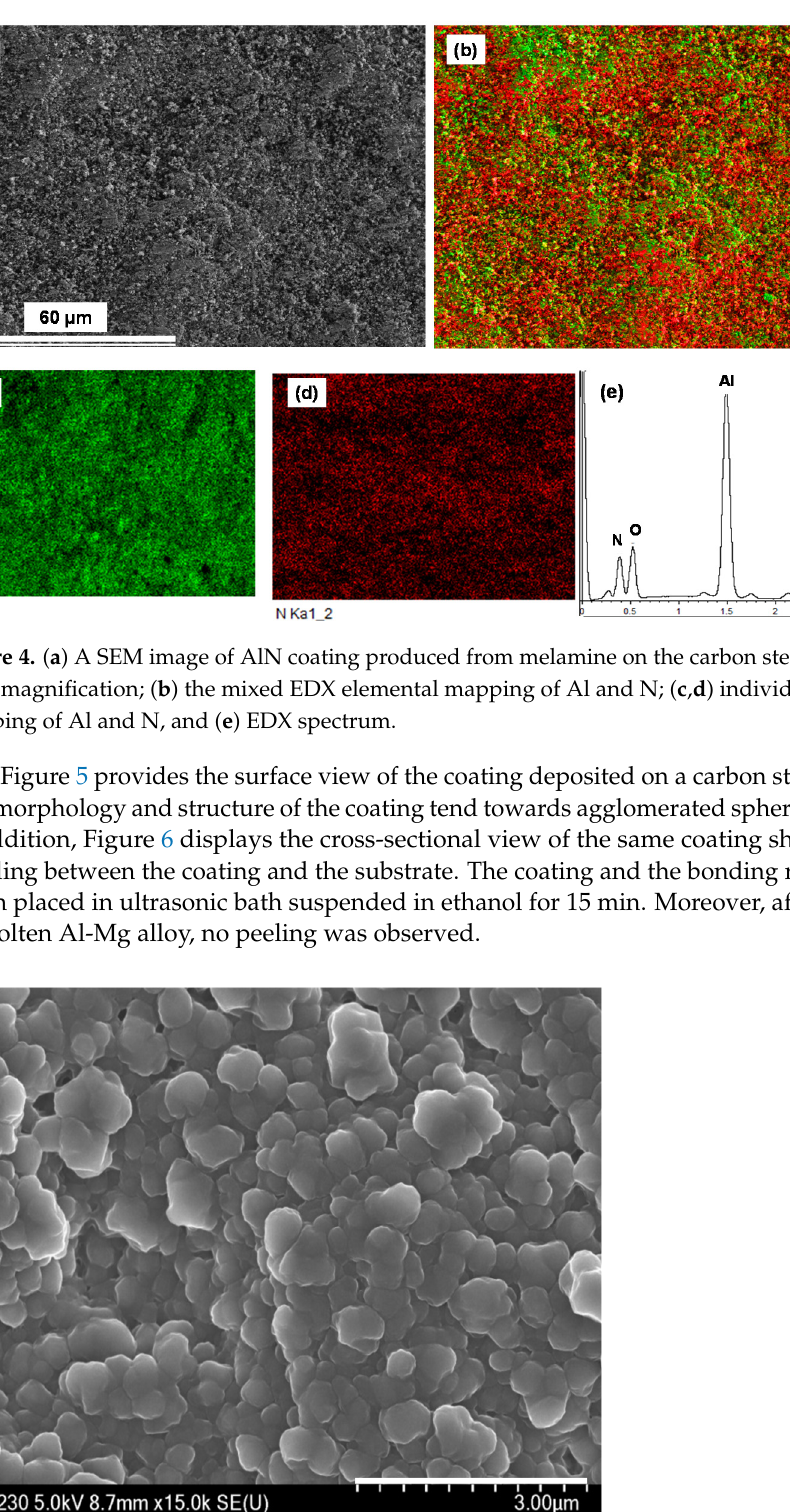
Figure 6. Cross sectional view of the AlN-rich coating on carbon steel by SEM imaging in ×2500 magnification. 3.2.2. XRD Analysis Various parameters were used to optimize the production of AlN coating as the target product. Figure 7 shows the XRD patterns of the two major peaks that were used to semi-quantitively determine the amount of the cubic AlN in the coatings, where the main peak at 44.85° 2 θ -angle represents the (200) plane, followed by the smaller (111) peak at approximately 38.59° 2 θ -angle. A comparatively higher intensity of the (111) peak than the (200) peak implies the presence of metallic Al, while an intense (200) peak accompanied by a smaller (111) peak implies the presence of AlN.